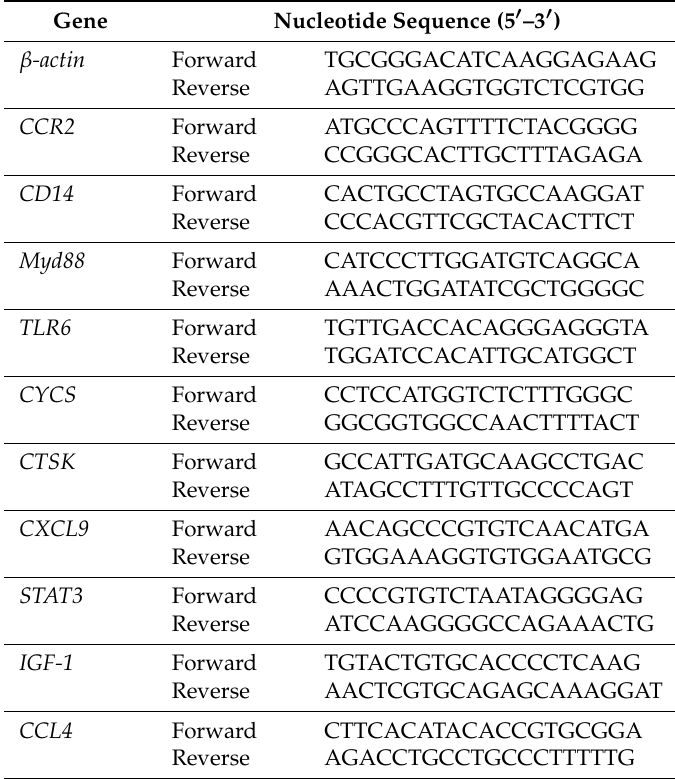
Table 2. Primers for